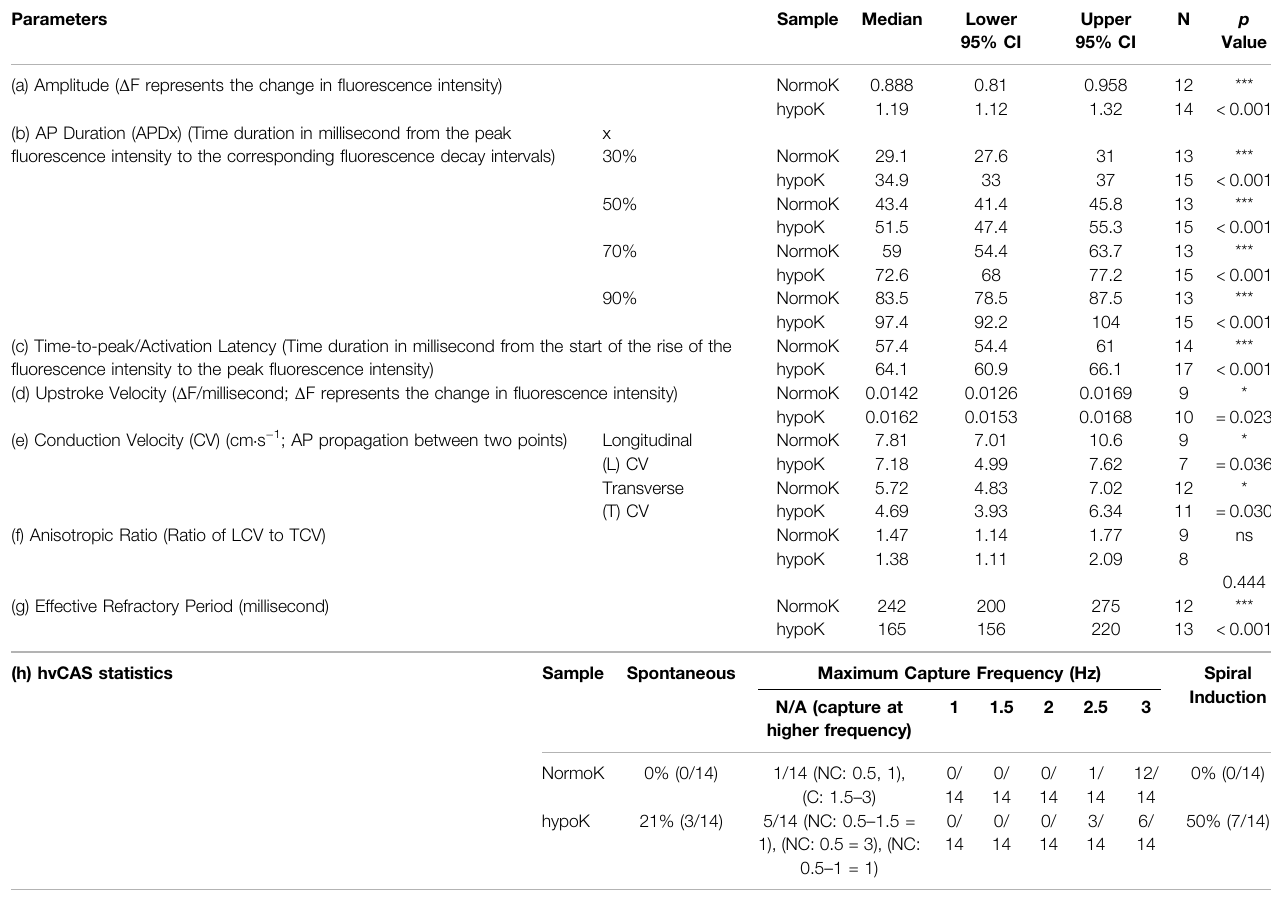
TABLE 1 | hES2-hvCAS Action Potential (AP) Parameters in acute hypokalaemia. Data analysis was performed for 1.5 Hz electrical stimulation recordings. Parameters